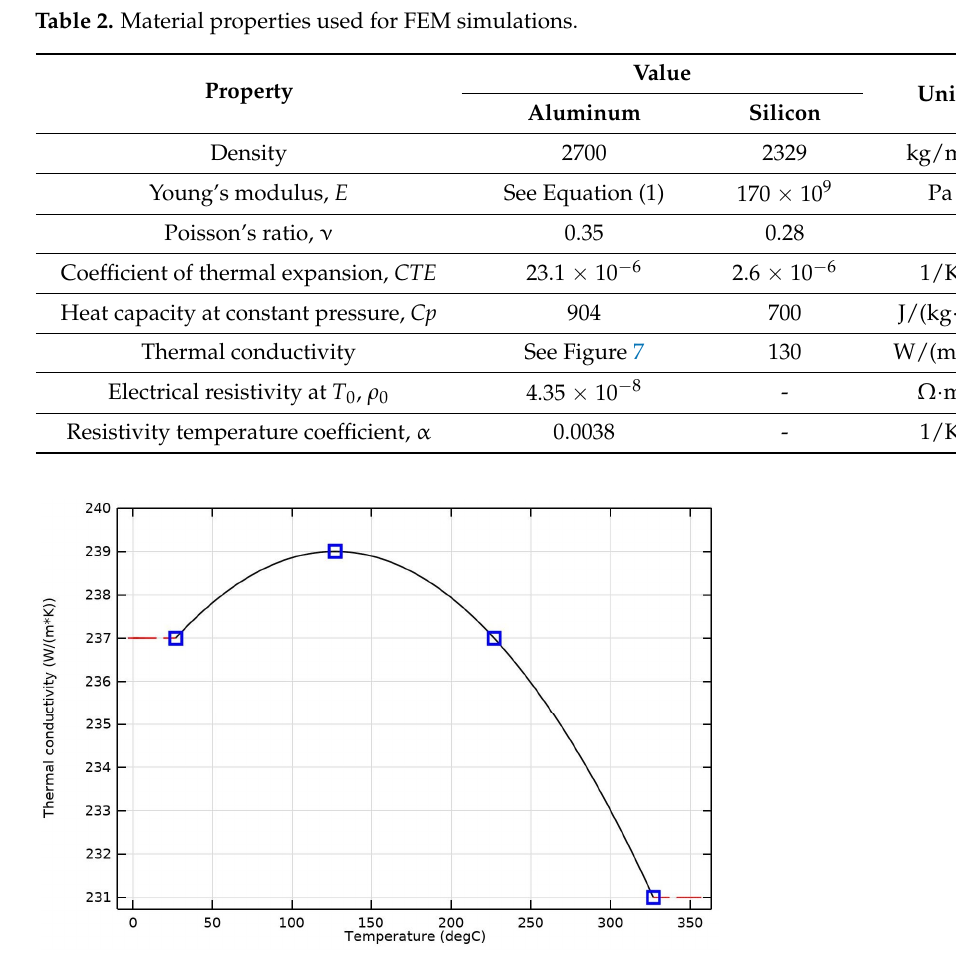
Figure 7. Interpolated values for aluminum thermal conductivity using cubic spline .